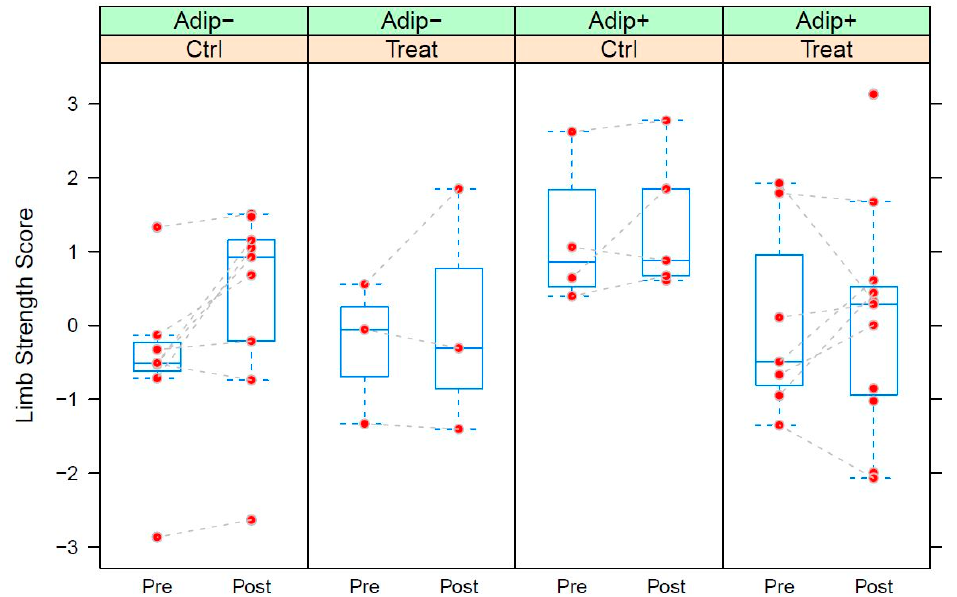
Figure 5. Box-plots of the Limb Strength Score (LS) calculated from the strength data of study B grouped by supplementation (Ctrl: control group; Treat: treatment group) within adiposity status (Adip − : BMI <30, Adip+: BMI >= 30). Pre: measurement before training intervention; Post: measure- ments after training intervention. LS corresponds to the 2nd principal component extracted from the strength data. See text for detailed explanation of the score. See capation of Figure 4 for details of the box-plots. Table 8. LME parameters fi tt ed to the limb-strength score (PC2, LS) of Study B. Value Std. Error